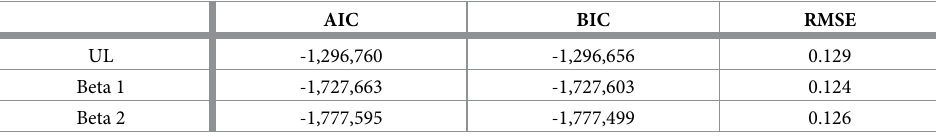
Table 6. Performance comparison of the selected regression models using AIC, BIC and RMSE (Phase I data).